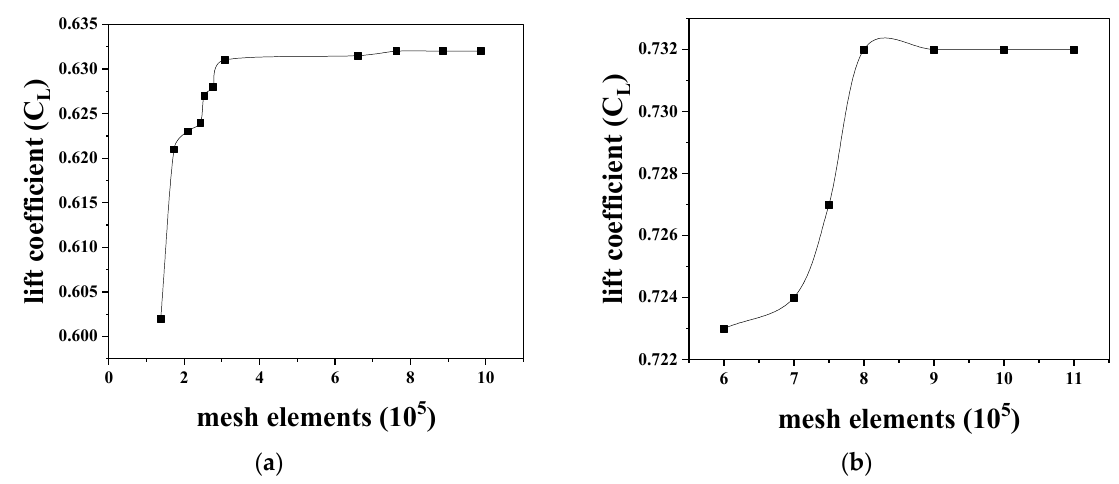
Figure 5. Mesh verification: ( a ) mesh independence for TEF airfoil S-809; ( b ) mesh independence for TEF with Micro-Tab (pattern 3).